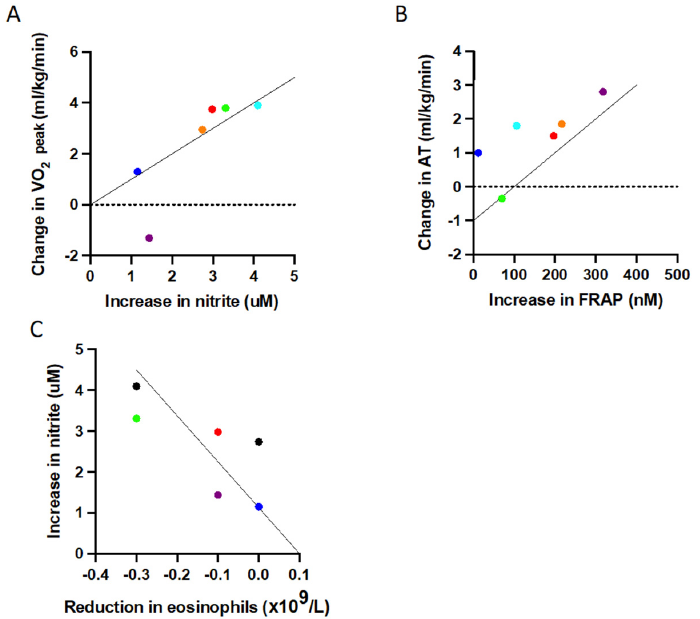
Figure 4. Significant correlations (Spearman’s rho correlation) between improvements in physical fitness, increased redox capacity and inflammation. ( A ) A greater increase in maximum oxygen uptake is associated with a greater increase in pre-CPET nitrite from baseline (r = 0.943, p = 0.019), ( B ) a greater increase in oxygen uptake at AT strongly correlates with a larger increase in FRAP (r = 0.886, p = 0.019), and ( C ) a greater increase in pre-CPET nitrite significantly correlates with a greater reduction in peripheral blood eosinophil levels (r = − 0.837, p = 0.038). Abbreviations AT: (oxygen uptake at) anaerobic threshold; FRAP: ferric reducing ability of